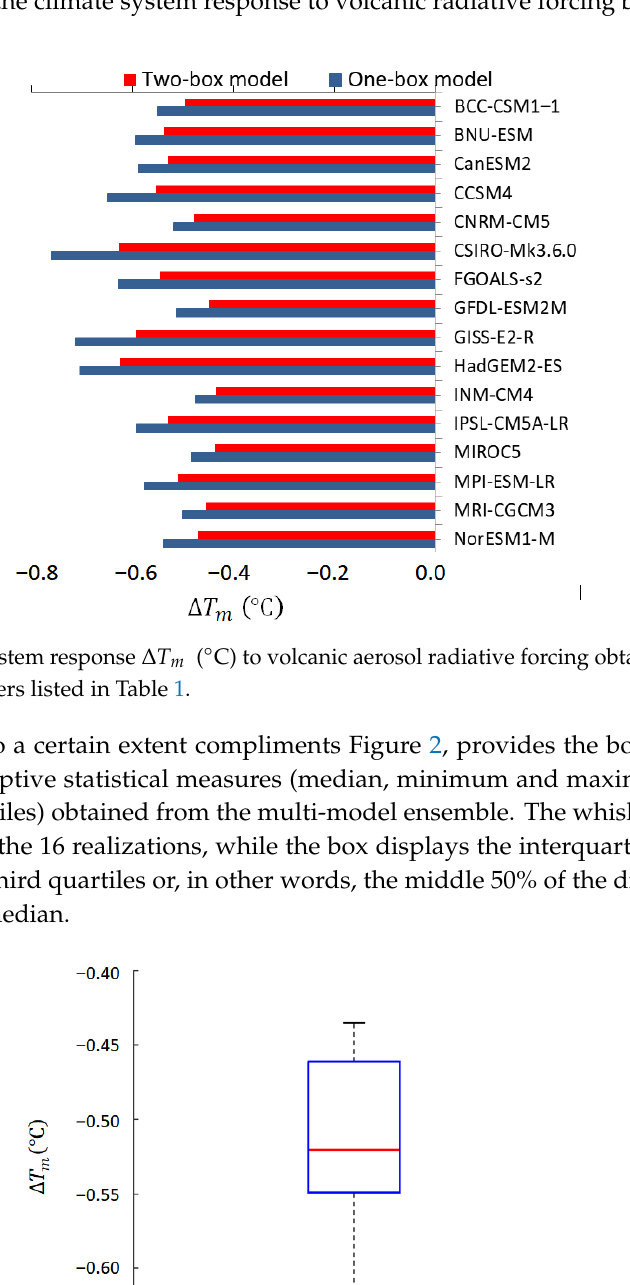
( b ) Figure 1. Global mean total optical depth 𝜏 𝐴 at 550 nm for the case of the Mount Pinatubo 1991 eruption ( a ) and the corresponding global mean surface temperature anomalies ∆𝑇 (℃) derived from running various energy balance models (EBMs) with parameters listed in Table 1 ( b ). As shown in Figure 1 (a), the global mean total optical depth would rise rapidly to a maximum